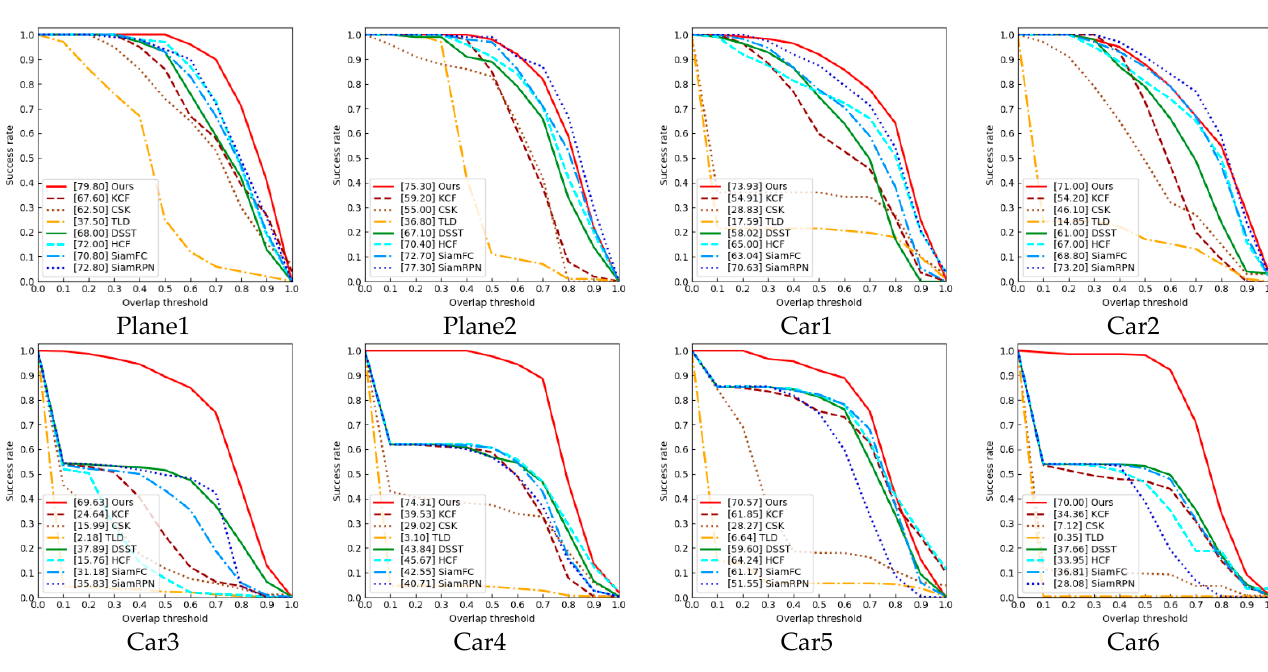
Figure 13. Success plots of eight video sequences involving object sequences without and with oc- clusion. The legend in the success plot presents the corresponding AUC per object tracker.